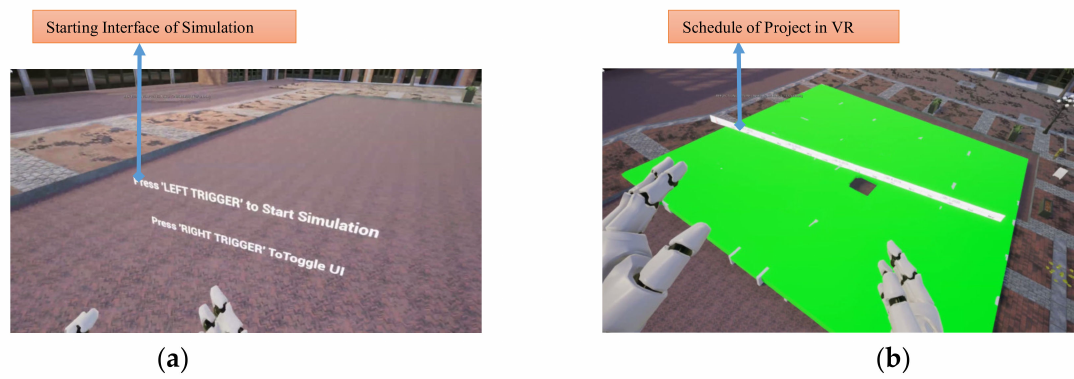
Figure 7. Simulation set up and process: ( a ) Start screen; ( b ) Live scheduled update of the